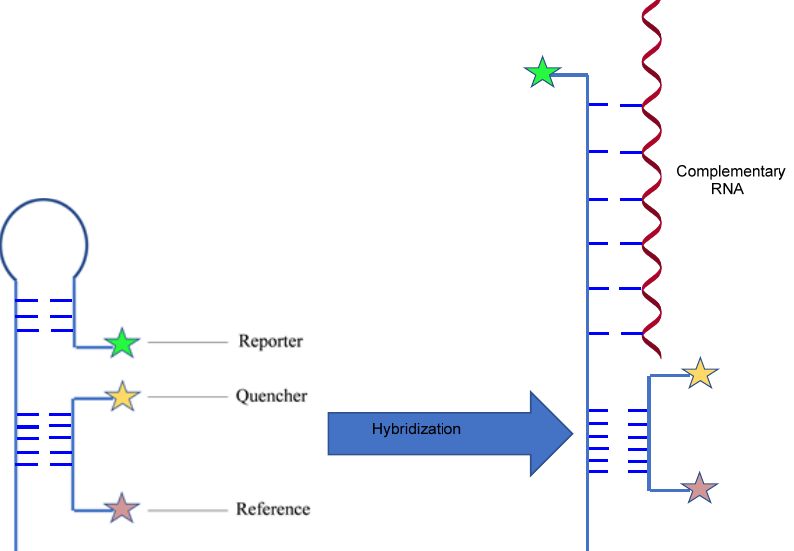
Figure 4. Schematic illustration of ratiometric bimolecular beacons (RBMB). It is initially in a weak fluorescence state because the quencher and reporter are close to each other; once the molecular beacon pairs with its complementary RNA, the reporter and quencher are separated, thus activating strong fluorescence.